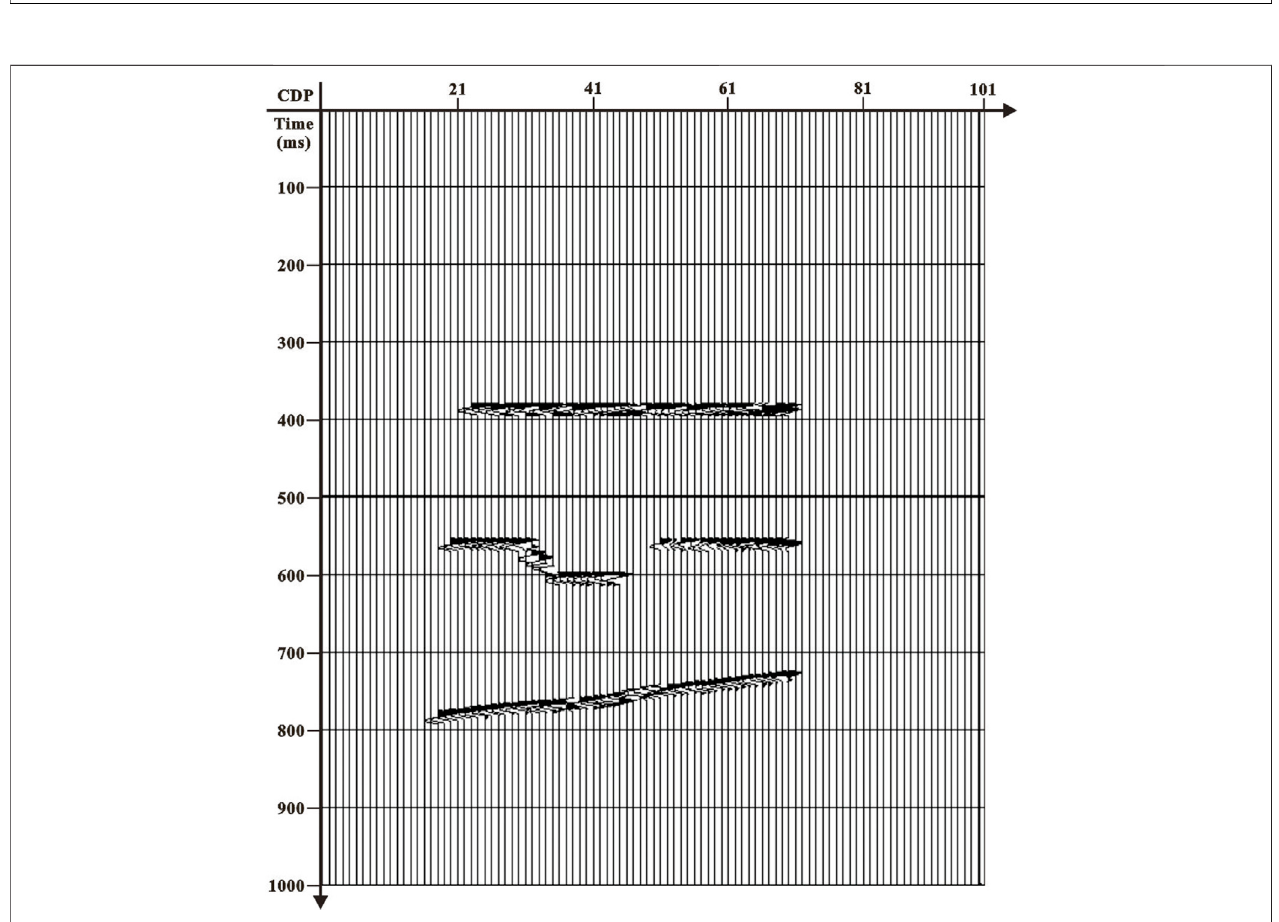
FIGURE 8 | Section of crosswell seismic inverse Fresnel beam stack imaging.